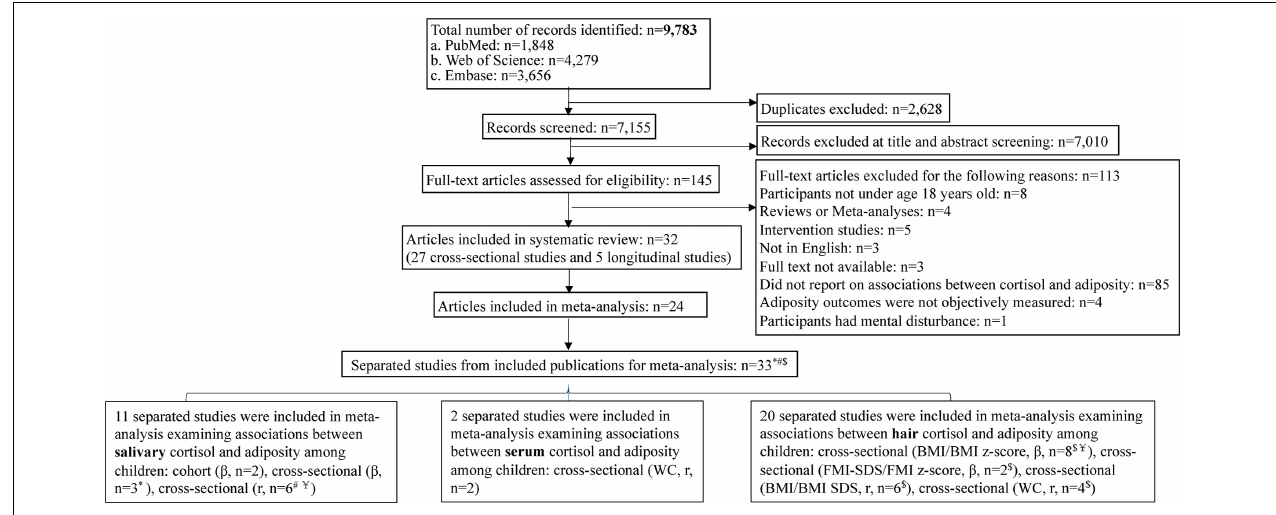
FIGURE 1 | Flowchart of the literature search and study selection procedures. ∗ Included articles were divided into separate studies by different age groups. # Included publications were divided into separate studies by gender. $ Included articles were divided into separate studies by different indicators of adiposity. Y = Included articles were divided into separate studies by different measurement of